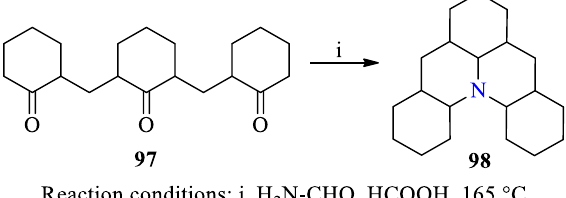
Figure 4. Another examples of Daphniphyllum alkaloids.